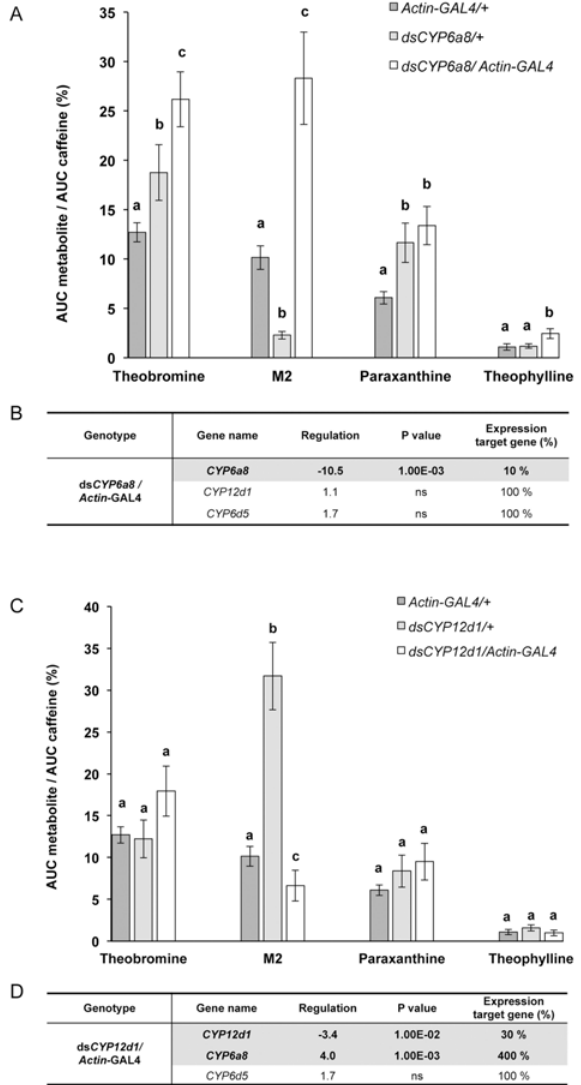
Fig 3. Influence of CYP6a8 and CYP12d1 genetic silencing in the metabolism of caffeine and gene expression. A and C: Comparison of normalized quantity of caffeine metabolites in males with respective silencing of CYP6a8 and CYP12d1 genes. The relative amount of metabolites was evaluated based on the intensity of the radiolabelled signal detected in the male bodies of experimental genotypes (ds CYP6a8 /+ and ds CYP12d1 /+ combined with Actin -GAL4/+) and transgenic controls. Bars represent mean values ( ± s.e.m.). For each metabolite, the statistical differences are indicated by different letters (ANOVA, n = 3). B and D: Comparison of fold change expression of CYP12d1 , CYP6a8 and CYP6d5 in ds CYP6a8 / Actin -GAL4 and ds CYP12d1 / Actin -GAL4, respectively, and their transgenic controls. The quantitative variation of transcript level was measured with RT-qPCR analysis. Data are shown as normalized expression fold variation compared to controls. Highlighted data indicate statistical differences (p < 0.01; n = 4). For detailed methods and statistics, please refer to legend of Fig.